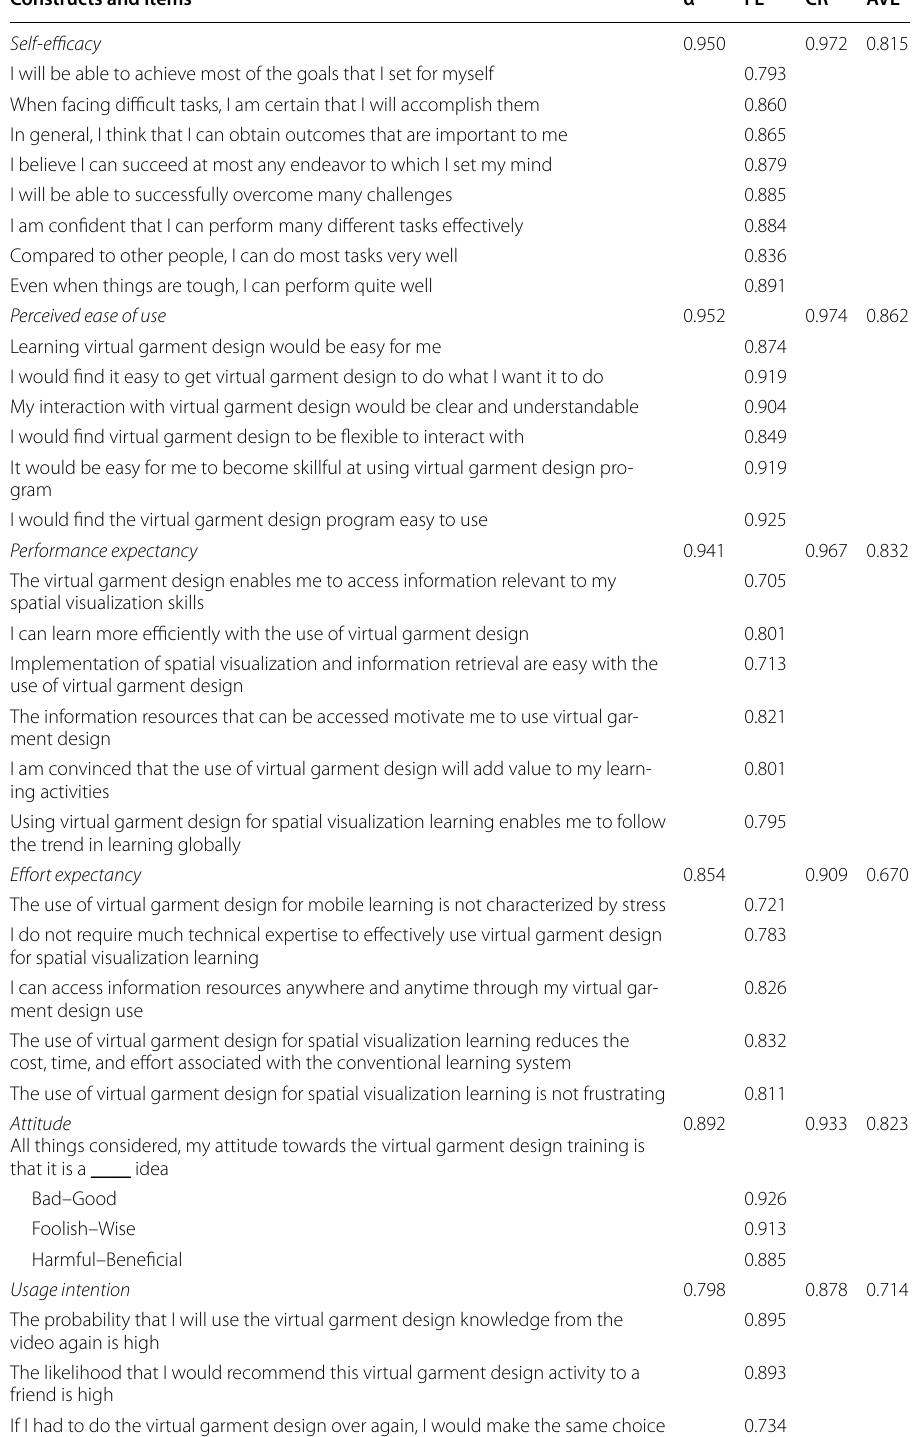
Table 3 The results of factor loading, reliability, and validity Constructs and items α FL CR AVE Self-efficacy